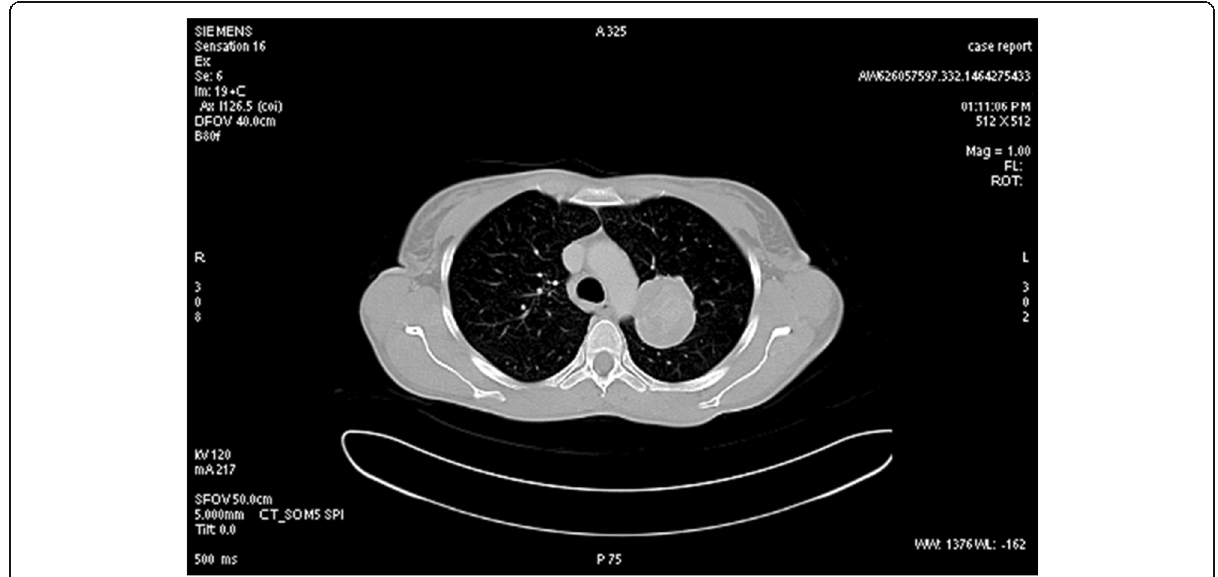
Fig. 1 Thoracic CT scan showing a mass (50 mm of maximum diameter) in the upper left